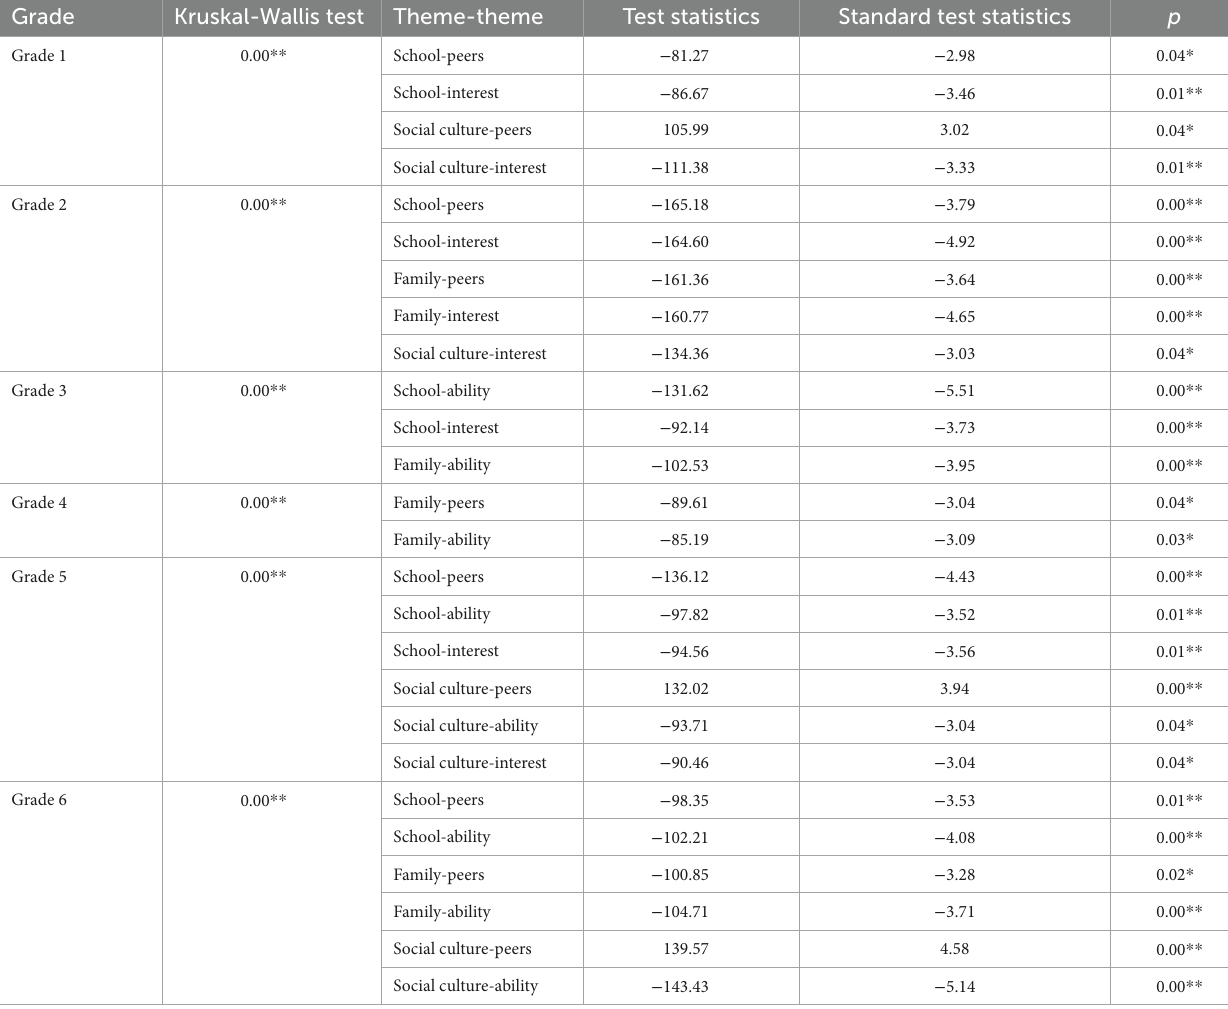
TABLE 5 The topic pairs with the significant pairwise comparison of sentiment in each